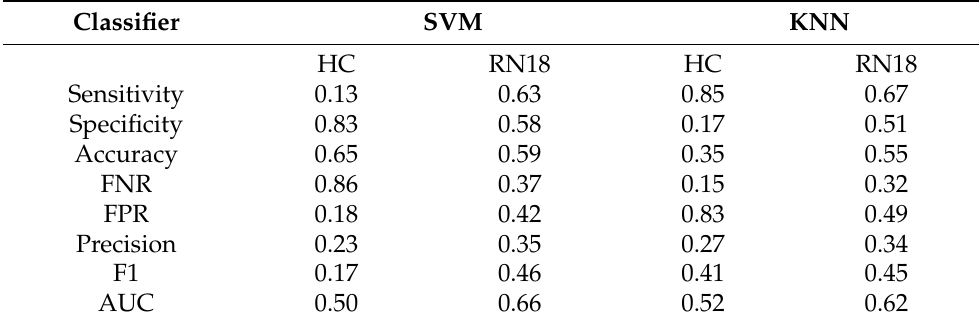
Table 4. Results with the hotBSI trained with support vector machine and k -nearest neighbors.